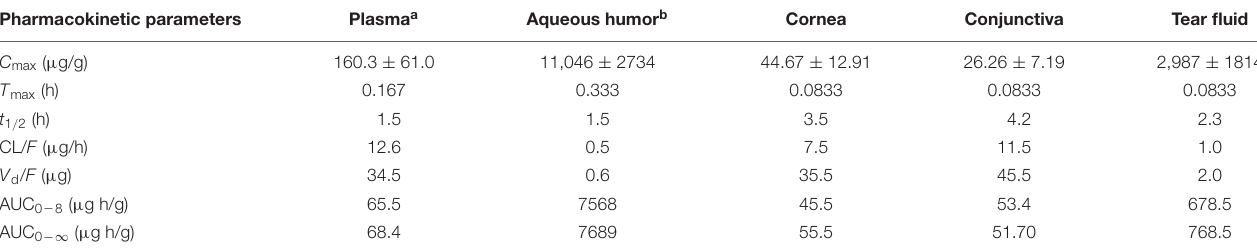
TABLE 3 | Pharmacokinetics of TSA in rat eye tissues and plasma after topical application. Pharmacokinetic parameters Plasma a